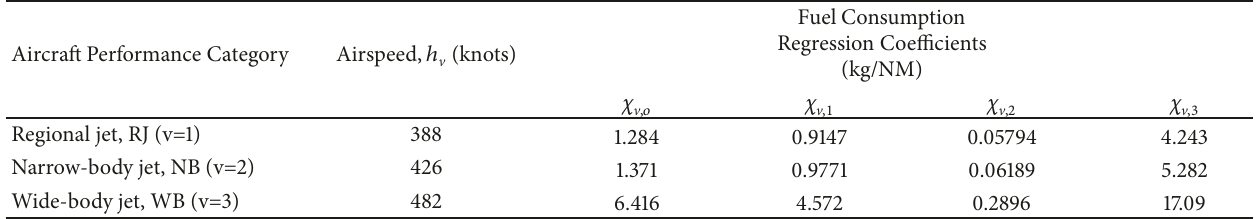
Table 1: Cruise airspeed and fuel consumption rates of aircraft performance categories at 33000